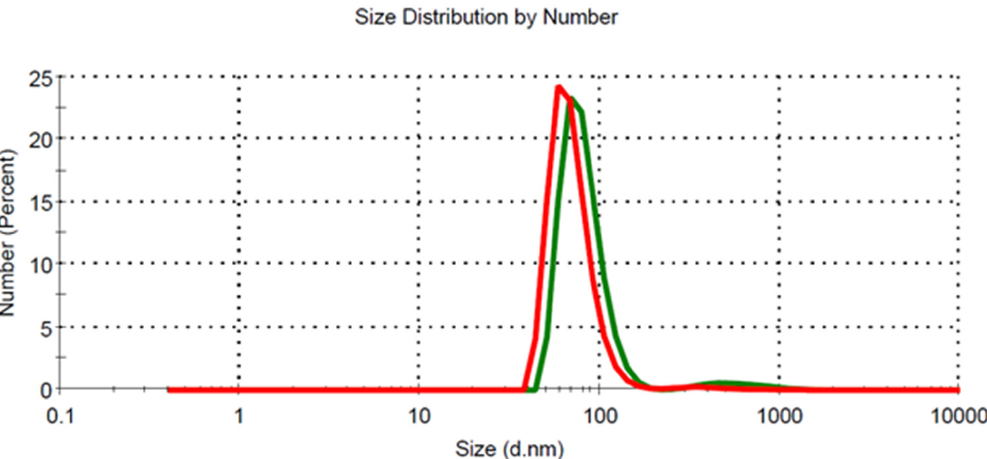
Figure 1. Size and size distribution of undiluted and freshly prepared microemulsion without Curcumin (red) and with Curcumin (green).